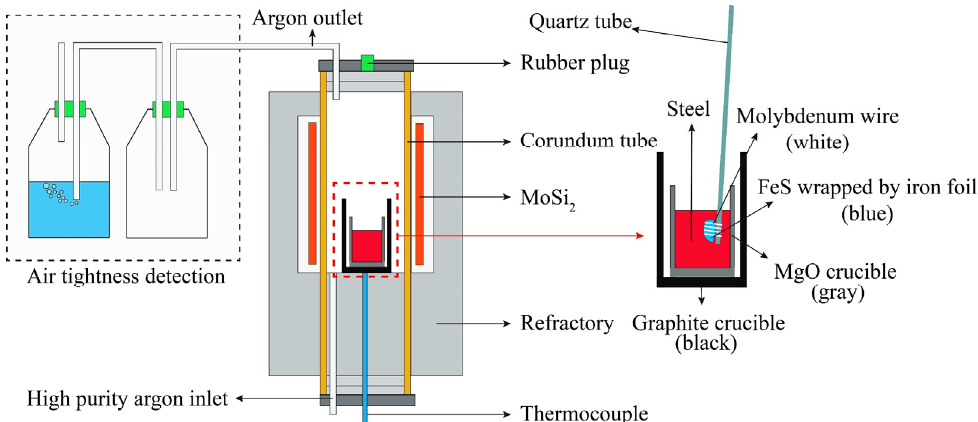
Figure 1. Sketch of experimental setup.